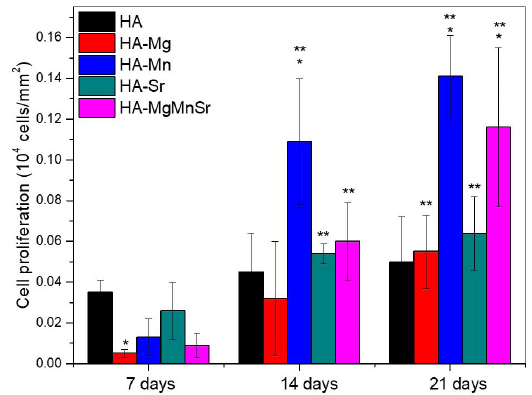
Figure 6. Typical time profile for MC3T3-E1 growth on the original and doped samples. *Significantly different from the HA sample at the same time point. **Significant difference between similar samples relative to the first time point (7